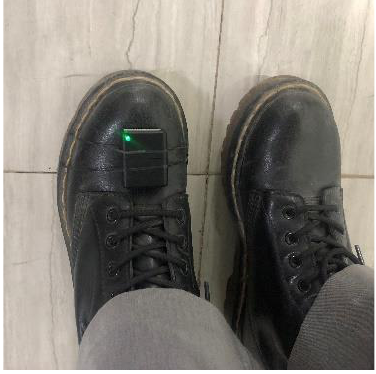
Figure 5 . IMU tied on the left foot.